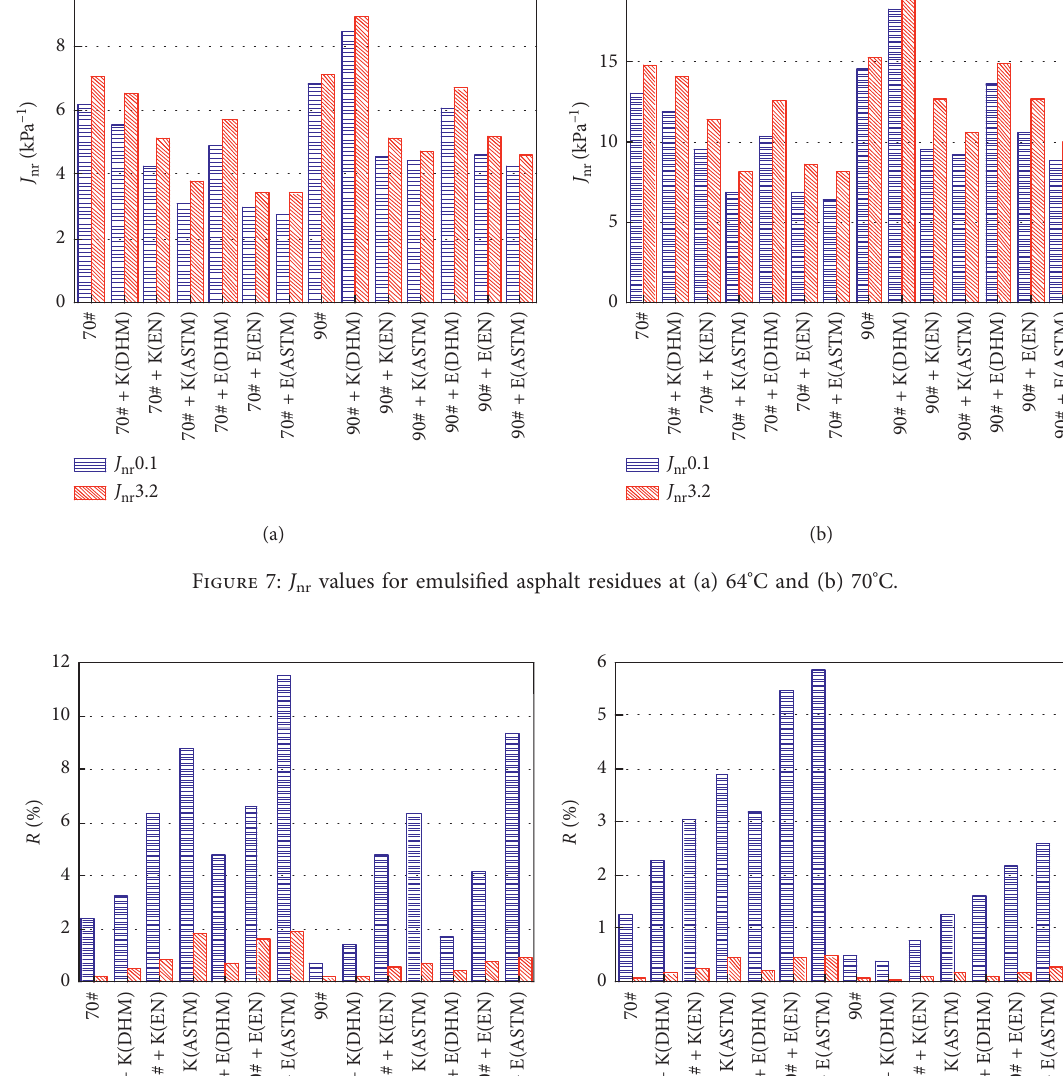
Figure 8: Percent recovery results for emulsion asphalt residues at (a) 64 ° C and (b) 70 °